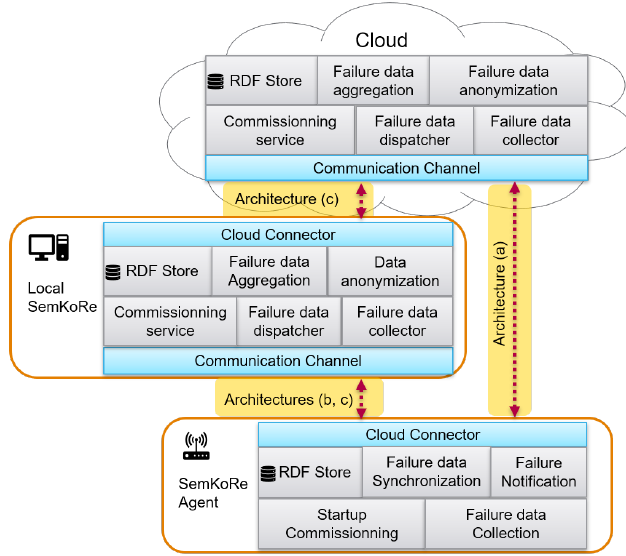
Figure 2. SemKoRe detailed